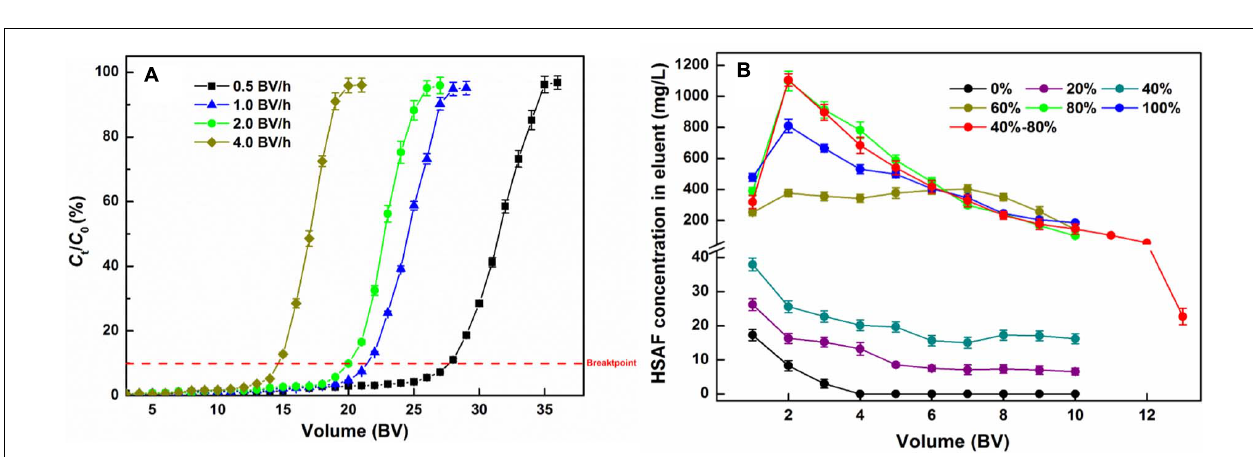
calculated as 34.72 ± 1.85, 26.57 ± 1.46, 25.12 ± 1.32,